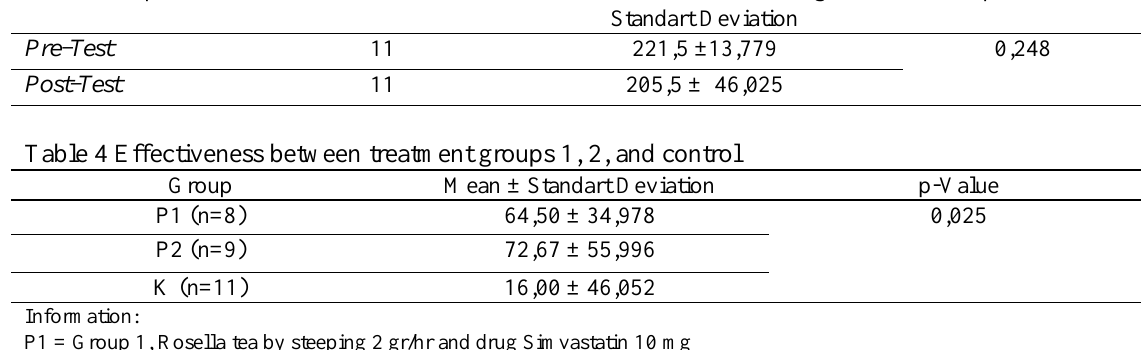
Table 3. Average total blood cholesterol levels before and after treatment in control group Group 3